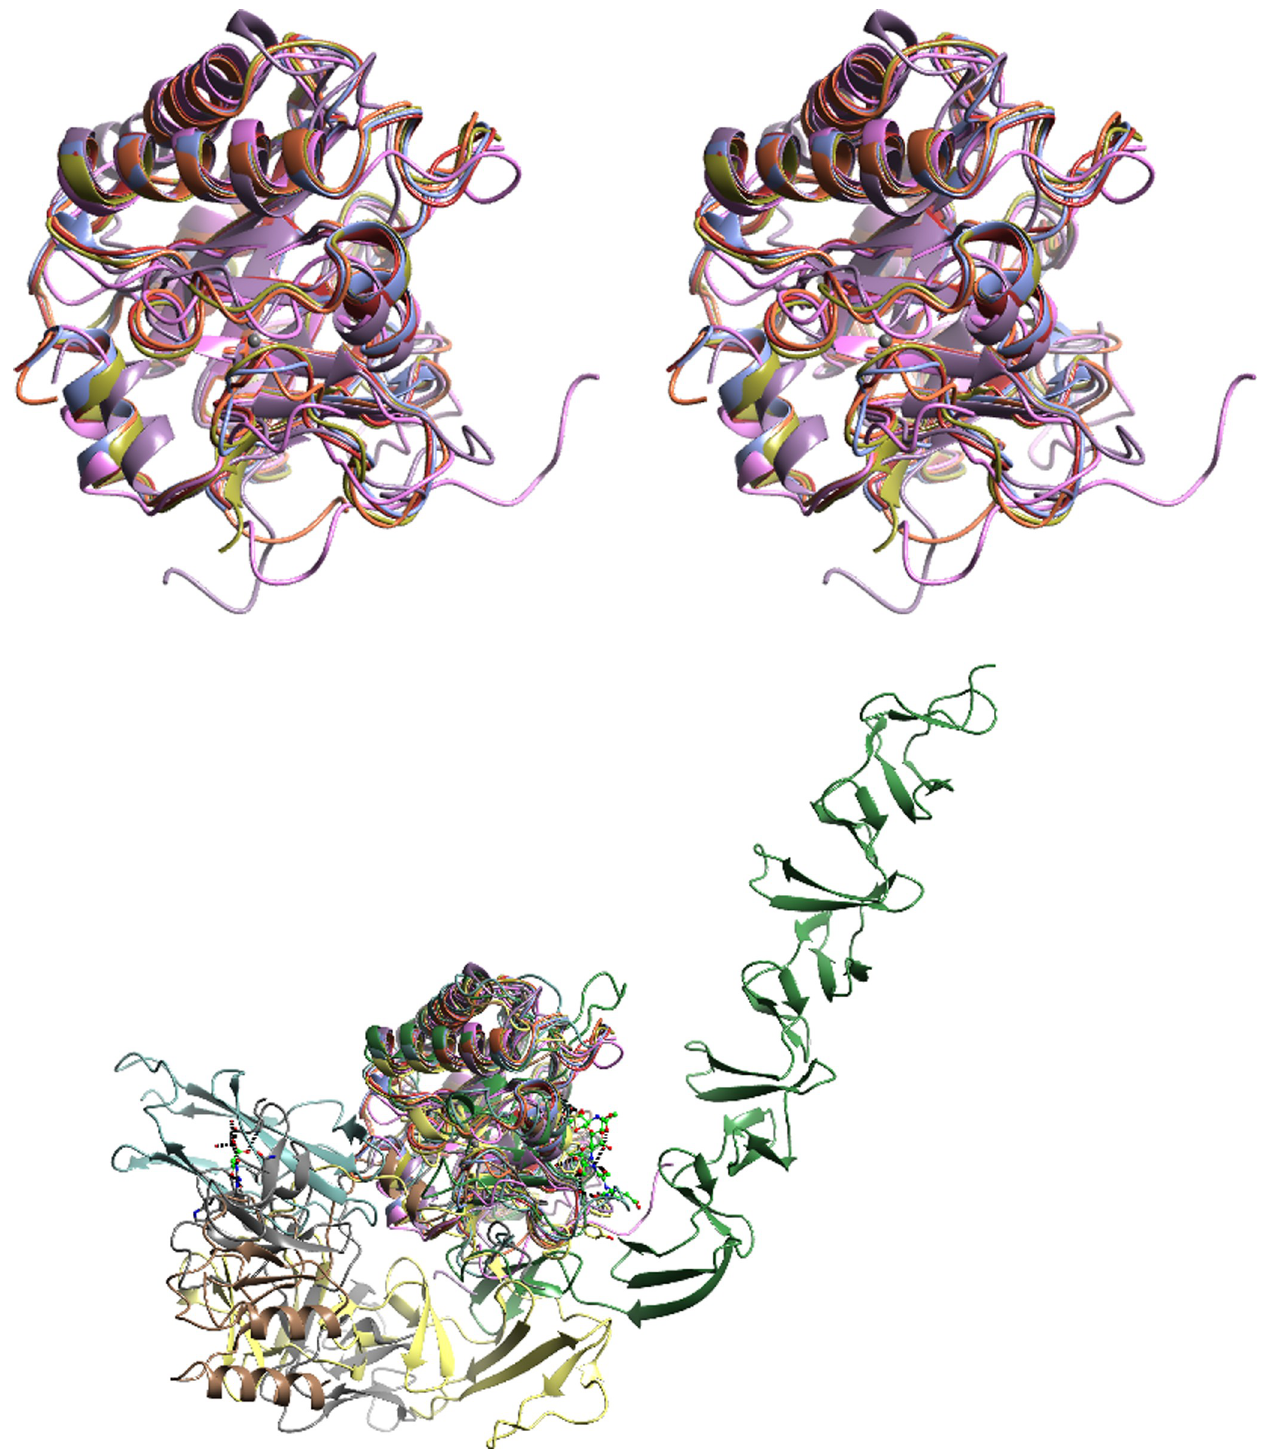
Fig 7. Structure comparisons. (a) Stereo view of a superposition of a representative set of GH25 enzymes ( Aa Mur, Tz Mur and PDB codes 2X8R, 1JFX, 2WAG and 4JZ5) with a single catalytic domain. The folds are seen to be highly conserved. (b) Superposition of the same enzymes with a set containing additional domains (PDB codes: 4KRT, 5JIP, 5A6S, 2IXU and 2WWD).